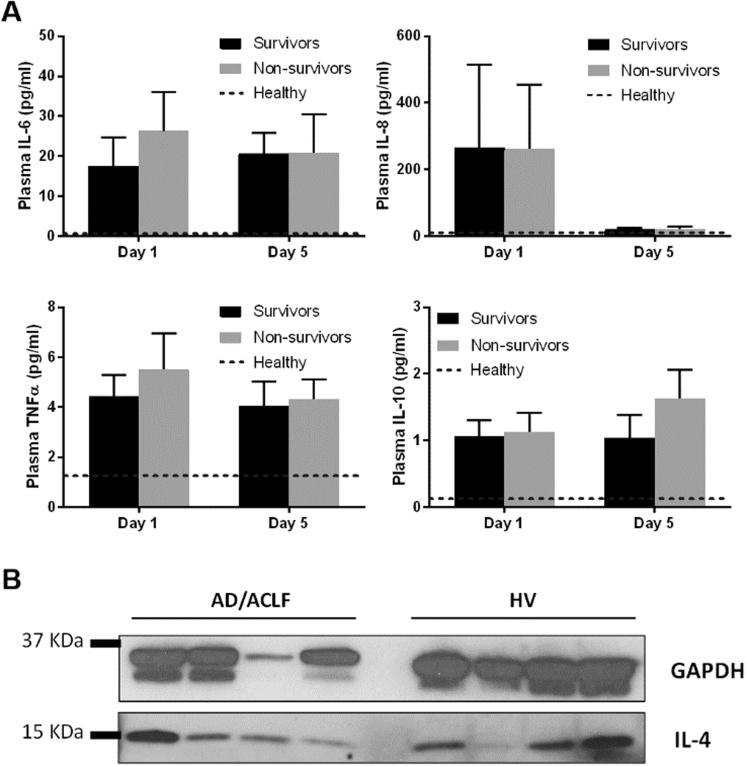
(A) Plasma cytokine levels on day 1 and day 5 samples from survivors (n = 8–9) and non-survivors (n = 7–8). Results are expressed as pg/mL, mean ± standard error of the mean. Dotted line represents mean levels on healthy volunteer plasma (n = 5). (B) IL4 was detected by immunoblotting on peripheral blood mononuclear cells of acutely decompensated (AD) patients and healthy volunteers (HV). Expression of GAPDH was used as input loading control. ACLF, acute-on-chronic liver failure; GAPDH, glyceraldehyde-3-phosphate dehydrogenase; IL, interleukin; TNF, tumor necrosis factor.